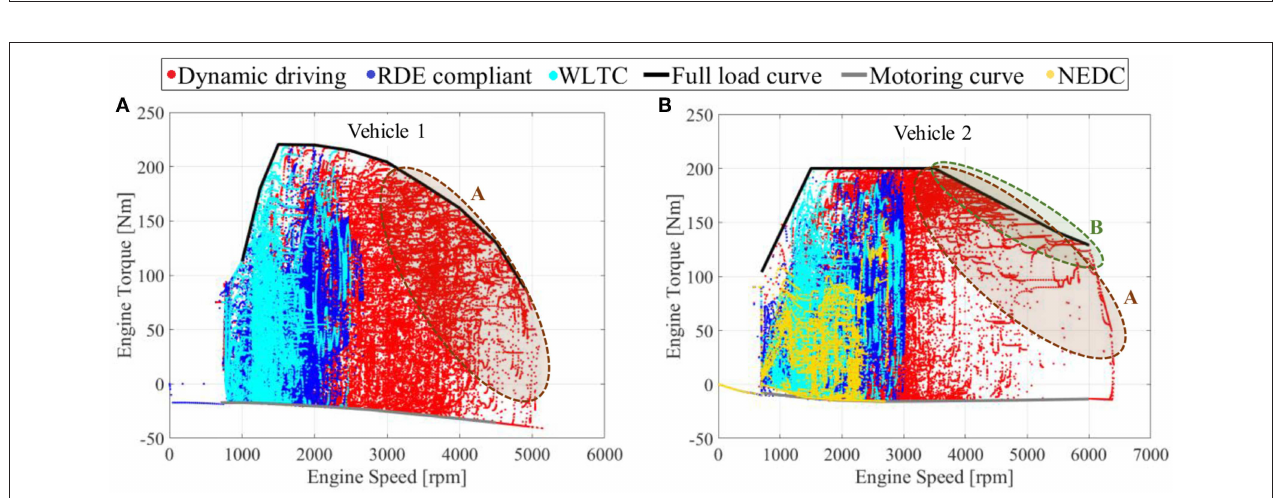
Figure 7 examines the correlation between CO 2 ( Figures 7A,B ) and NO x ( Figures 7C,D ) emissions and cycle dynamics. The latter is quantified by two